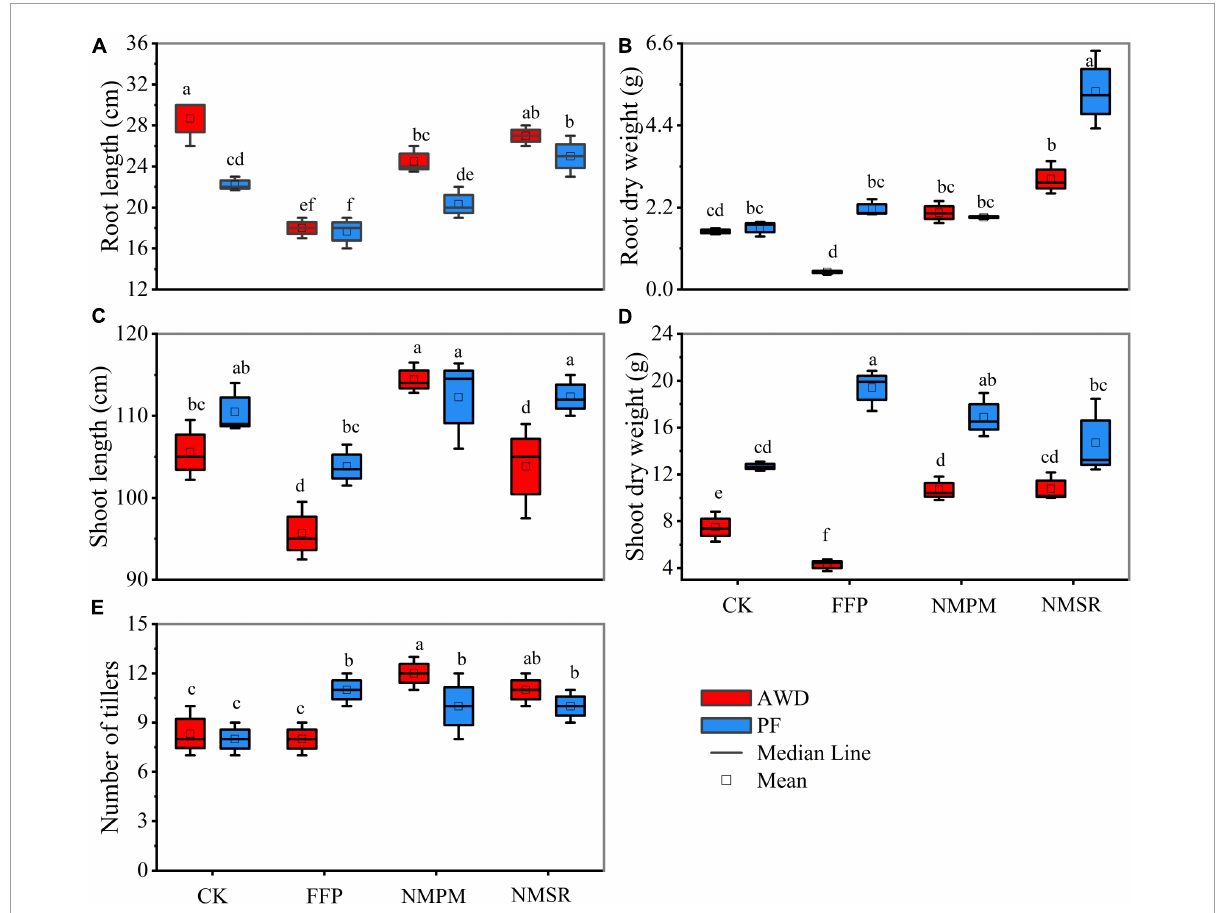
FIGURE1 Combined effects of different fertilizer treatments during alternate wetting and drying (AWD) and permanent flooding (PF) on dry matter accumulation, that is, (A) root length, (B) root dry weight, (C) shoot length, (D) shoot dry weight, and (E) number of tiller. The arrow bar above the line shows standard error. The different letters show significant difference, while the same letters represent no significant differences among the